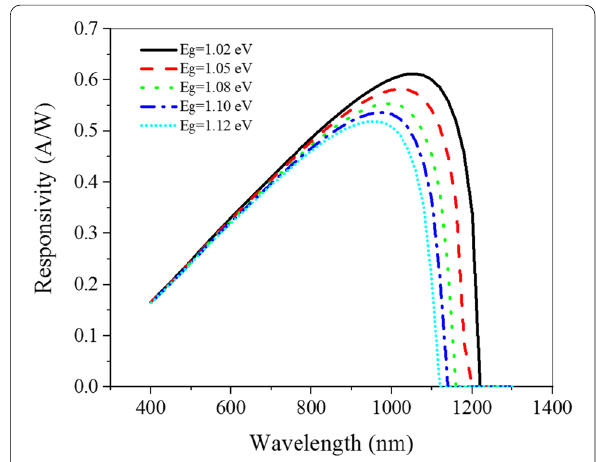
Fig.8 Responsivity of black silicon by different bandgap